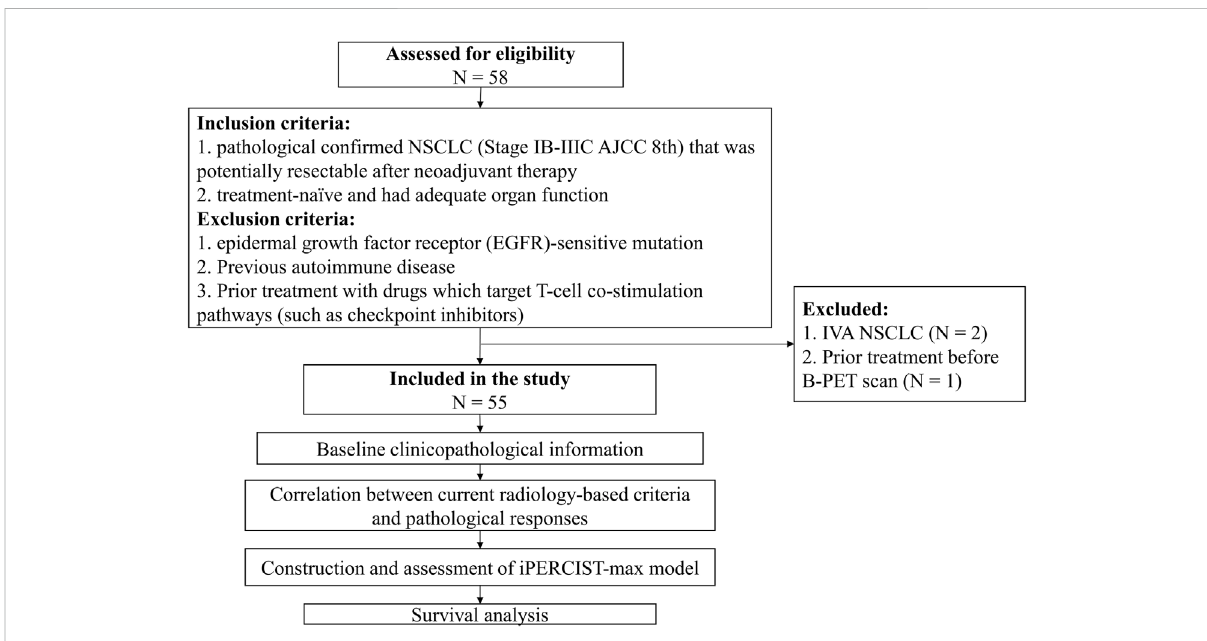
FIGURE 1 Flowchartofthestudydesign.Fifty-eightpatientswereassessedforeligibility;eventually, fi fty- fi